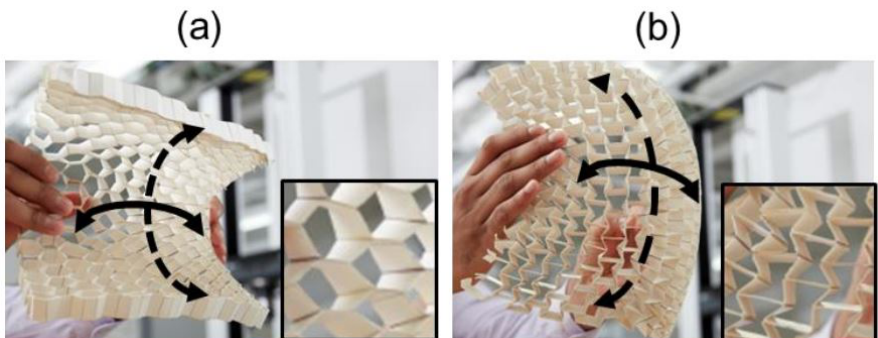
Figure 8. Curvature in bending: ( a ) anticlastic curvature of conventional, non-auxetic materials and ( b ) synclastic curvature of auxetic materials. Reprinted with permission from Ref. [37]. Copy- right 2018, MDPI AG.